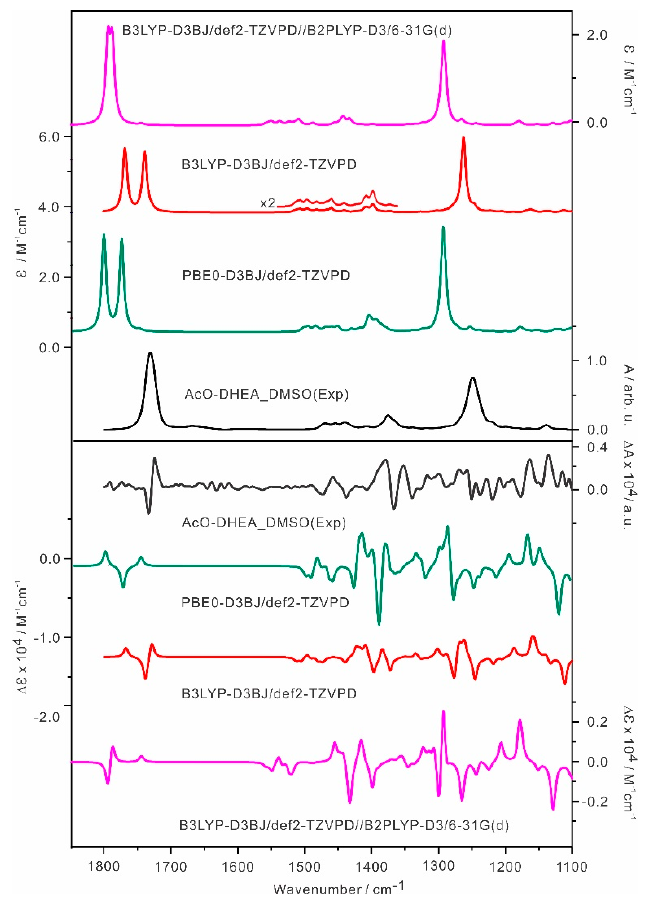
Figure 9. Comparison of the experimental and simulated IR and VCD spectra of AcO − DHEA at these different levels: B3LYP − D3BJ/def2 − TZVPD, PEB0 − D3BJ/def2 − TZVPD and B3LYP − D3BJ/def2 − TZVPD//B2PLYP − D3/6 − 31G(d) with the PCM of DMSO.